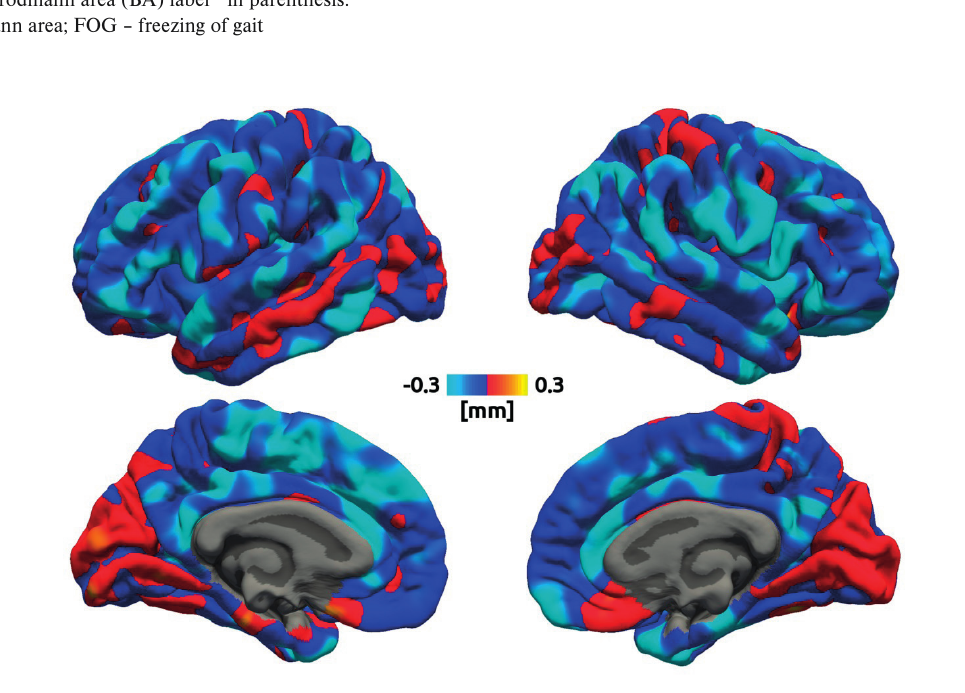
Fig. 1. Average cortical thickness difference between FOG- and FOG+. Colour overlay shows vertex-wise average difference in cortical thickness (in mm) on top of an average three-dimensional cortical surface reconstruction. The cold colours represent greater atrophy in FOG+ group, whereas warm colours represent greater atrophy in FOG- group. Left columns show the left hemisphere, right columns show the right